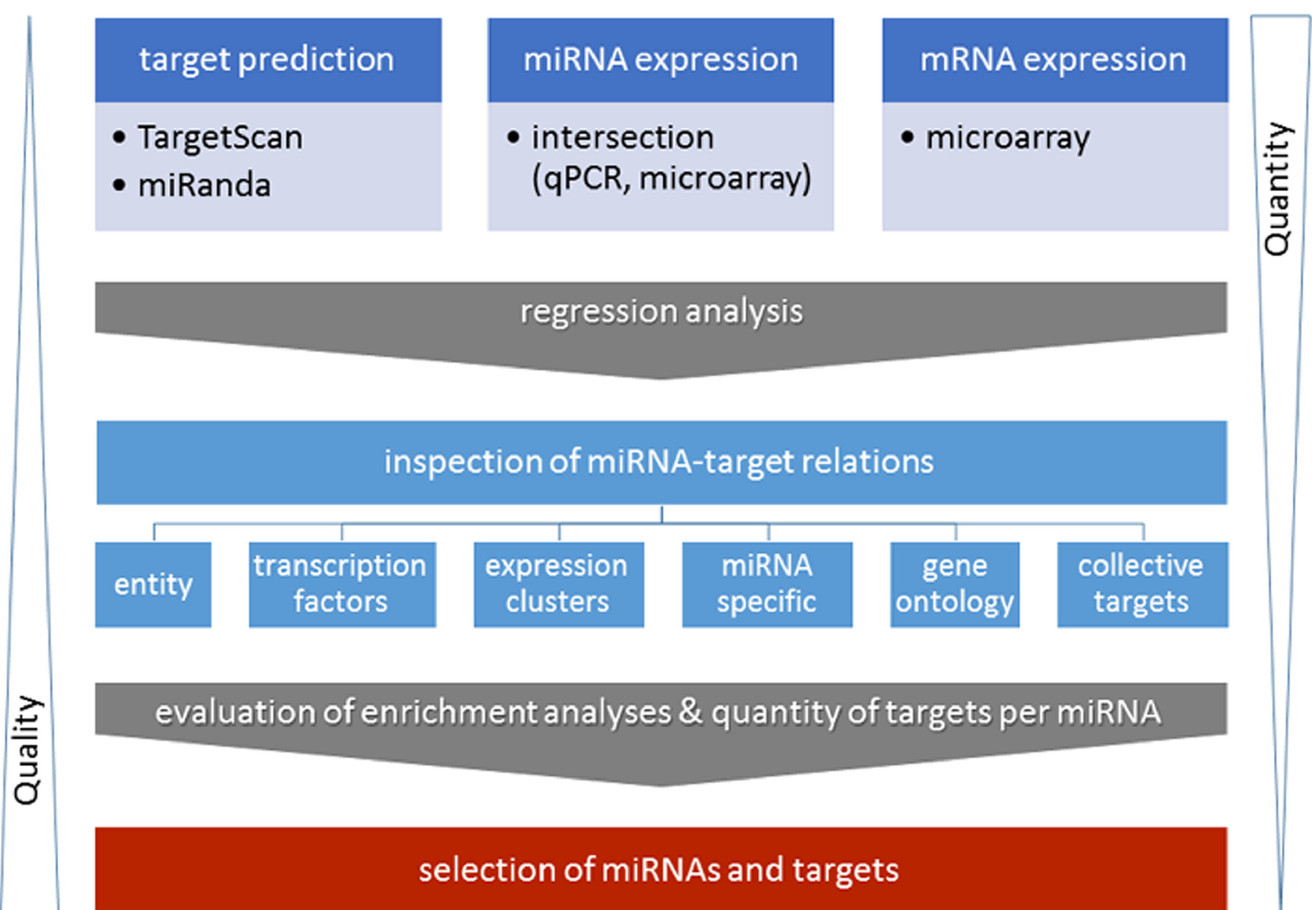
Fig 1. Joint analysis of miRNA and mRNA expression data. Schematic overview of the integrative analysis of miRNA target prediction based on TargetScan (www.targetscan.org/) and miRanda (www.microrna.org/) and paired miRNA/mRNA expression data derived from the same experiments. The graphic is an extension and modification of Fig 1 published by Meyer and co-workers 2014 [15]. The expression data included the intersection dataset derived from miRNA microarray and miRNA qPCR profiling experiments and was inversely associated to mRNA microarray data. Predicted miRNA-target relations from integrated analysis were evaluated according to different criteria: Criteria which can be considered for mRNA-miRNA selection include: the total number of miRNA targets per miRNA, the number of transcription factors per miRNA, enrichment of targets in gene expression clusters, or gene ontology terms of all selected miRNAs or miRNA specific target enrichments, as well as the number of collective miRNA targets. The workflow allowed multi- aspect based interpretation of the results, reduced the quantity of miRNA-mRNA target relations, and increased the prediction quality with respect to potential biological